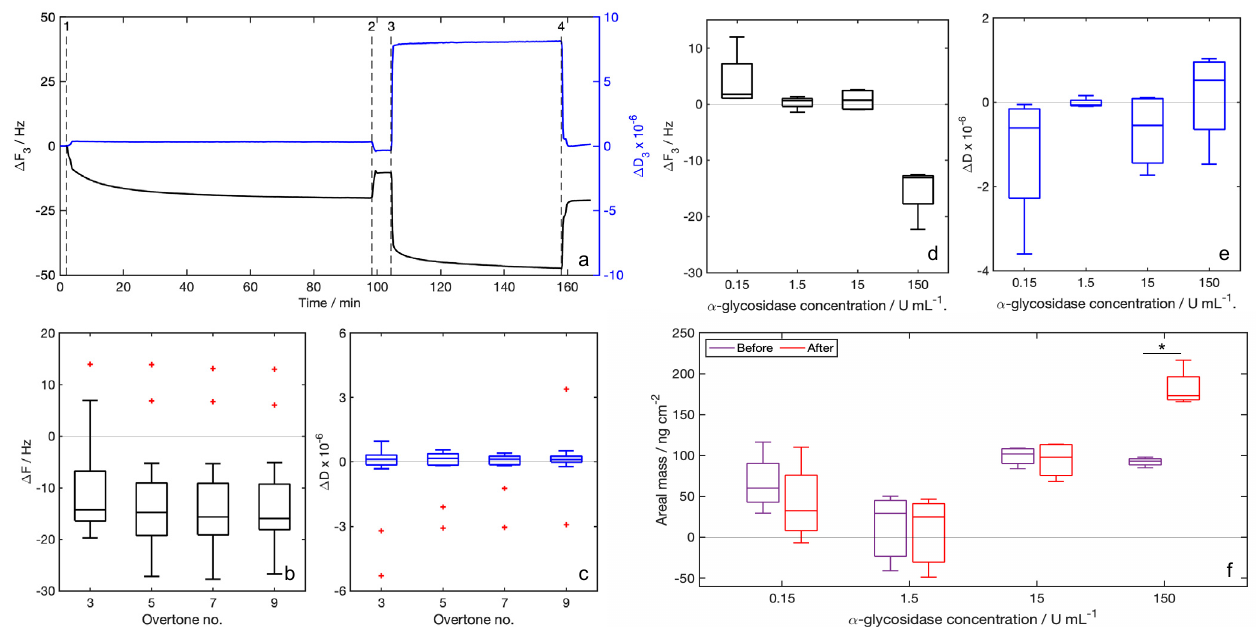
Figure 3. Results of QCM-D measures: ( a ) traces acquired during the experiments (black: Δ F , blue: Δ D ) referred to the third overtone, events: (1) functionalization solution injection, (2) rinsing with water, (3) enzyme solution (150 U/mL) injection, (4) rinsing with water, reported traces are related to the experiment with enzyme concentration of 150 U/mL; ( b ) Δ F measured after rinsing with water for the functionalization for the selected overtones ( n = 16 for each overtone); ( c ) Δ D measured after rinsing with water for the functionalization for the selected overtones ( n = 16 for each overtone); ( d ) Δ F 3 measured after rinsing with water for the injection of different enzyme concentrations ( n = 4 for each enzyme concentration), values are calculated as Δ F between events 4 and 3; ( e ) Δ D 3 measured after rinsing with water for the injection of different enzyme concentrations ( n = 4 for each enzyme concentration), values are calculated as Δ D between events 4 and 3; ( f ) probe areal masses (ng cm − 2 ) calculated from Δ F 3 using the Sauerbrey equation (Equation (1)). For this calculation, experiments giving outliers, indicated by the red crosses in plots b and c, after the functionalization, are elimi- nated ( n = 4 in all cases except for the experiment with enzyme concentration 1.5 U/mL, for which n = 3), values are calculated as Δ F between events 4 and 1. Statistical tests are performed comparing the frequency shift due to functionalization and to samples, * indicates p < 0.1, obtained from a Mann–Whitney U-test. 3.3. SAW Device Measures Readouts acquired with the SAW-LoC sensor after the functionalization with the syn- thesized probe and the injection of different-concentration enzyme solutions (Figure 4a) indicate negative frequency shifts in all cases. The signal related to the sensor functional- ization result was − 131 kHz ± 13 kHz. We also registered a small signal of − 24 kHz ± 13 kHz related to the PBS used as enzyme buffer. The sum of those signals, equal to − 158 kHz ± 14 kHz, was considered the baseline for the following enzyme detection experiments. The frequency shifts read after the injection of the enzyme solutions with the higher (150 U/mL) and the lower (0.15 U/mL) concentrations were negligible, while significant posi- tive net frequency shifts were read after the injection of the enzyme solutions with inter- mediate concentrations (1.5 U/mL and 15 U/mL). Control experiments obtained the injection over the functionalized sensor surface of a solution containing the enzyme (15 U/mL) and its inhibitor acarbose (2.5 mg/mL). The final shifts (Figure 4b), calculated using the signal acquired for the free surface as a base- line, were − 42 ± 10 kHz and − 171 ± 5 kHz.